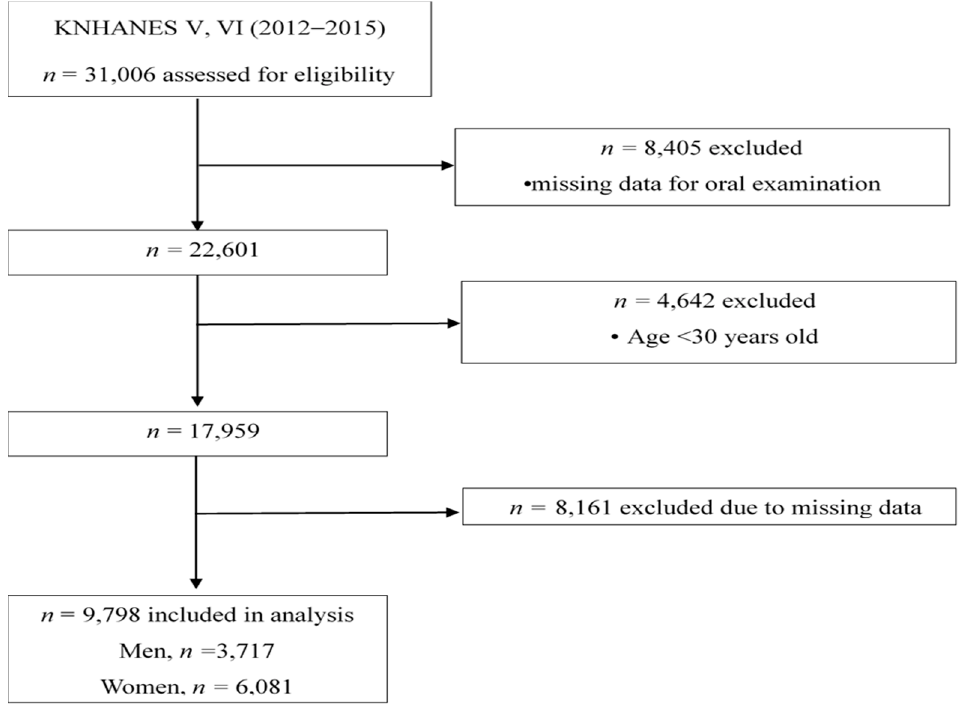
Figure 1. Flow chart for selection of study population.